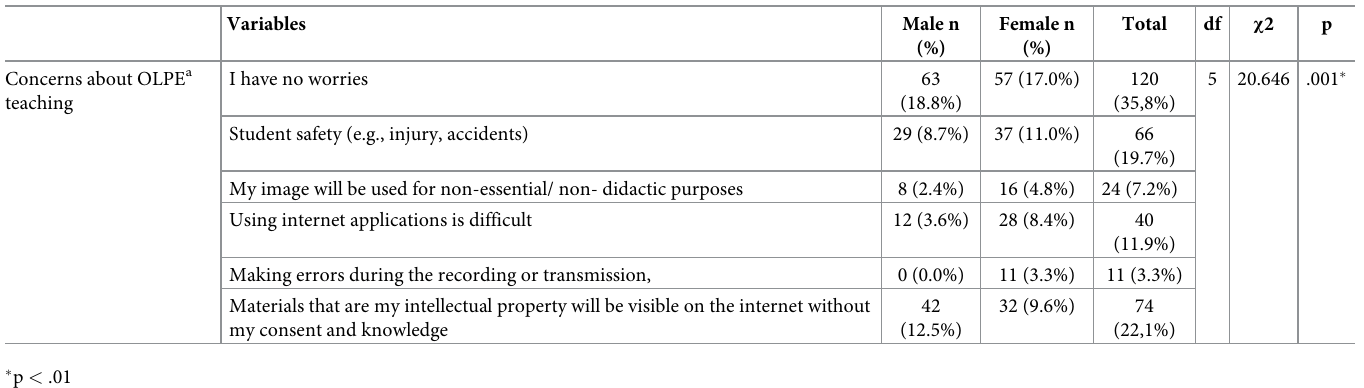
Table 4. Pets’ opinions on the concerns about online physical education teaching by